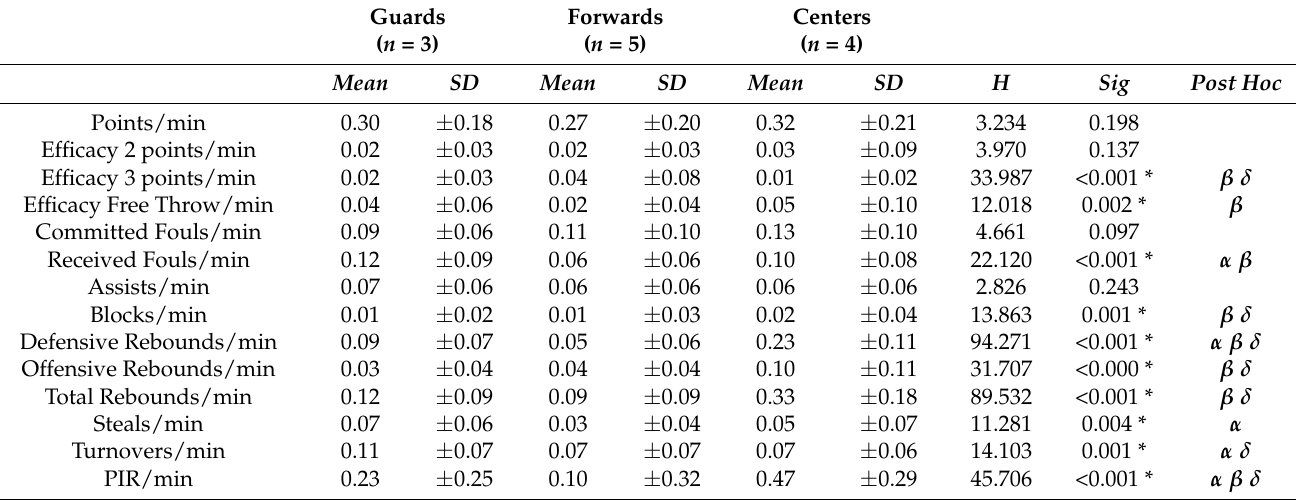
Table 4. Descriptive and inferential results of game indicators relativized per minute grouped by game position and the differences between female